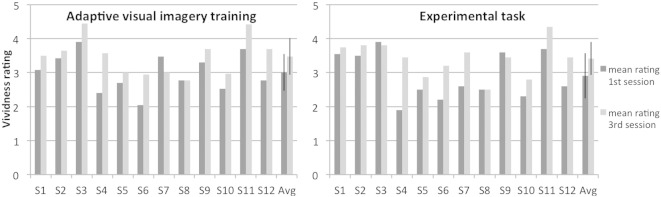
Mean vividness ratings for adaptive visual imagery and experimental task in training sessions. Mean ratings for the vividness of imagery (1: “No image at all, you only ‘know’ that you are thinking of the object” to 5: “Perfectly clear and vivid as normal vision”) are shown for all subjects (S1 through S8) for the first and the last training session in the adaptive visual imagery training (left) and the experimental task (right). The last columns show the group averages (Avg); error bars indicate one standard deviation.